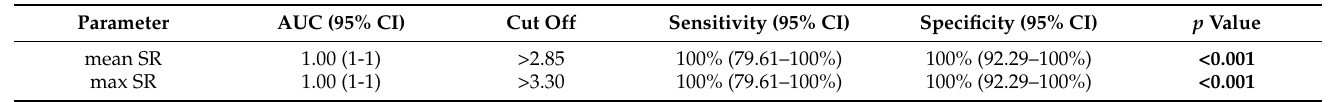
Table 3. ROC analysis of mean and max SR values for differentiation between leiomyoma and controls.